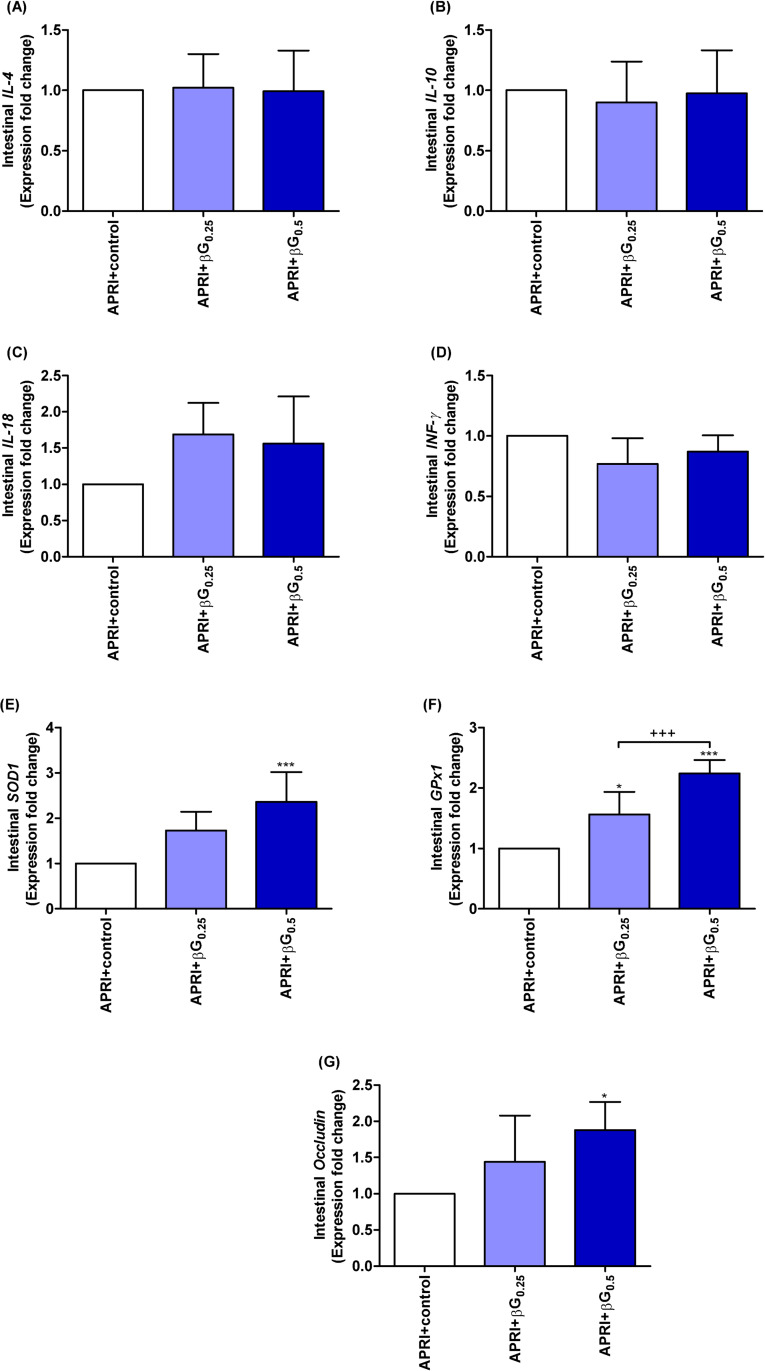
RT-PCR validation of the intestinal (A) interleukin-4 (IL-4), (B) interleukin-10 (IL-10), (C) interleukin-18 (IL-18), (D) interferon-γ (IFN-γ), (E) superoxide dismutase 1 (SOD1), (F) glutathione peroxidase 1 (GPx1), and (G) occludin genes in APRI rabbits. *P < 0.05 and ***P < 0.001 vs. control. +++P < 0.001 vs. APRI+βG0.25. Statistical analysis was performed using one-way ANOVA and Tukey's post hoc test for multiple comparisons.